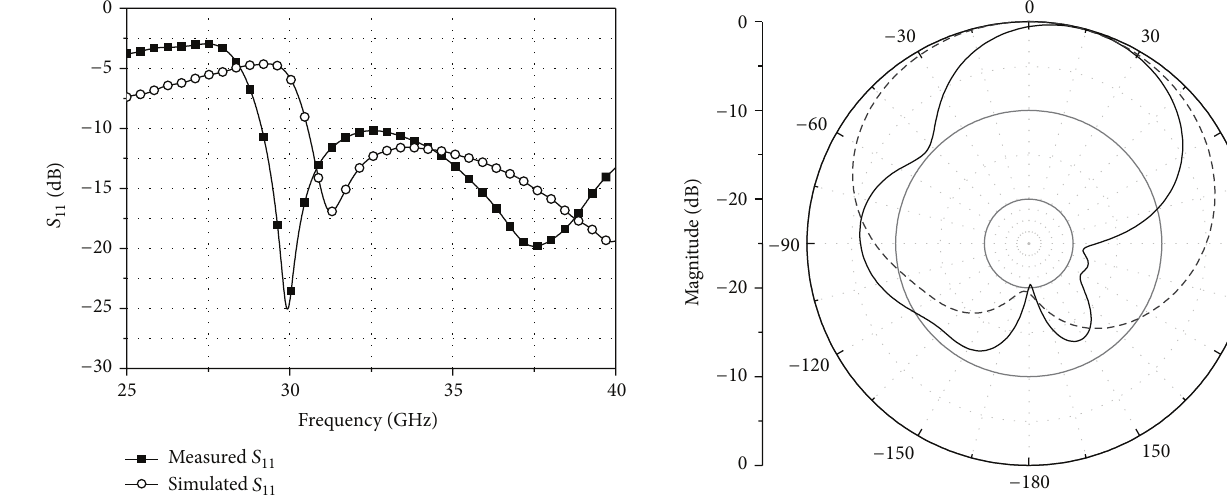
Figure 4: Simulated and measured return loss of the proposed antenna.